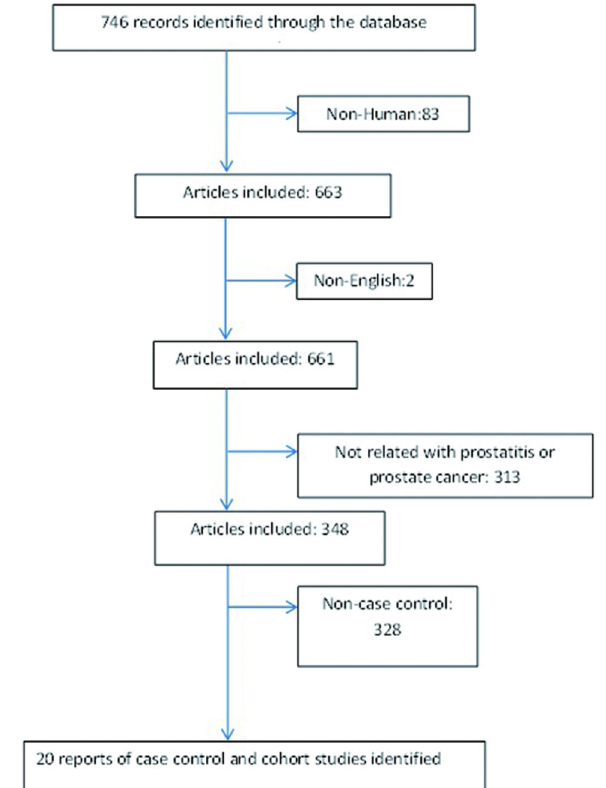
A flow diagram of the study